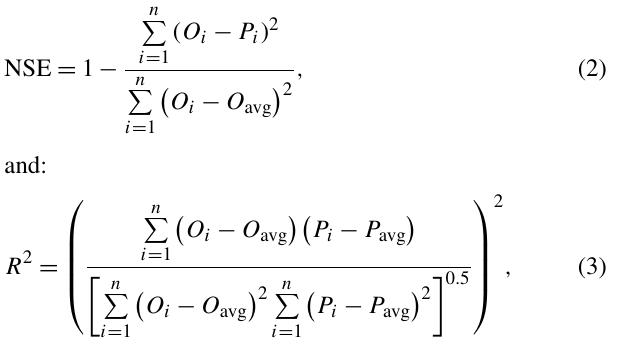
cessed using ERDAS Imagine 2014 and ArcGis 10.2.2. Su- pervised classification method was used by creating land use classes based on their respective spectral